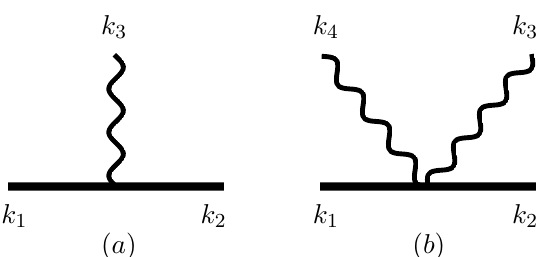
Figure 1 . The Feynman vertices used to compute full-theory amplitudes. The three-particle vertex (a) determines the O ( G ) dynamics. The Compton amplitude, which requires the contact vertex (b), captures the O ( G 2 ) dynamics. The straight lines correspond to the spinning particle, while the wiggly lines correspond to